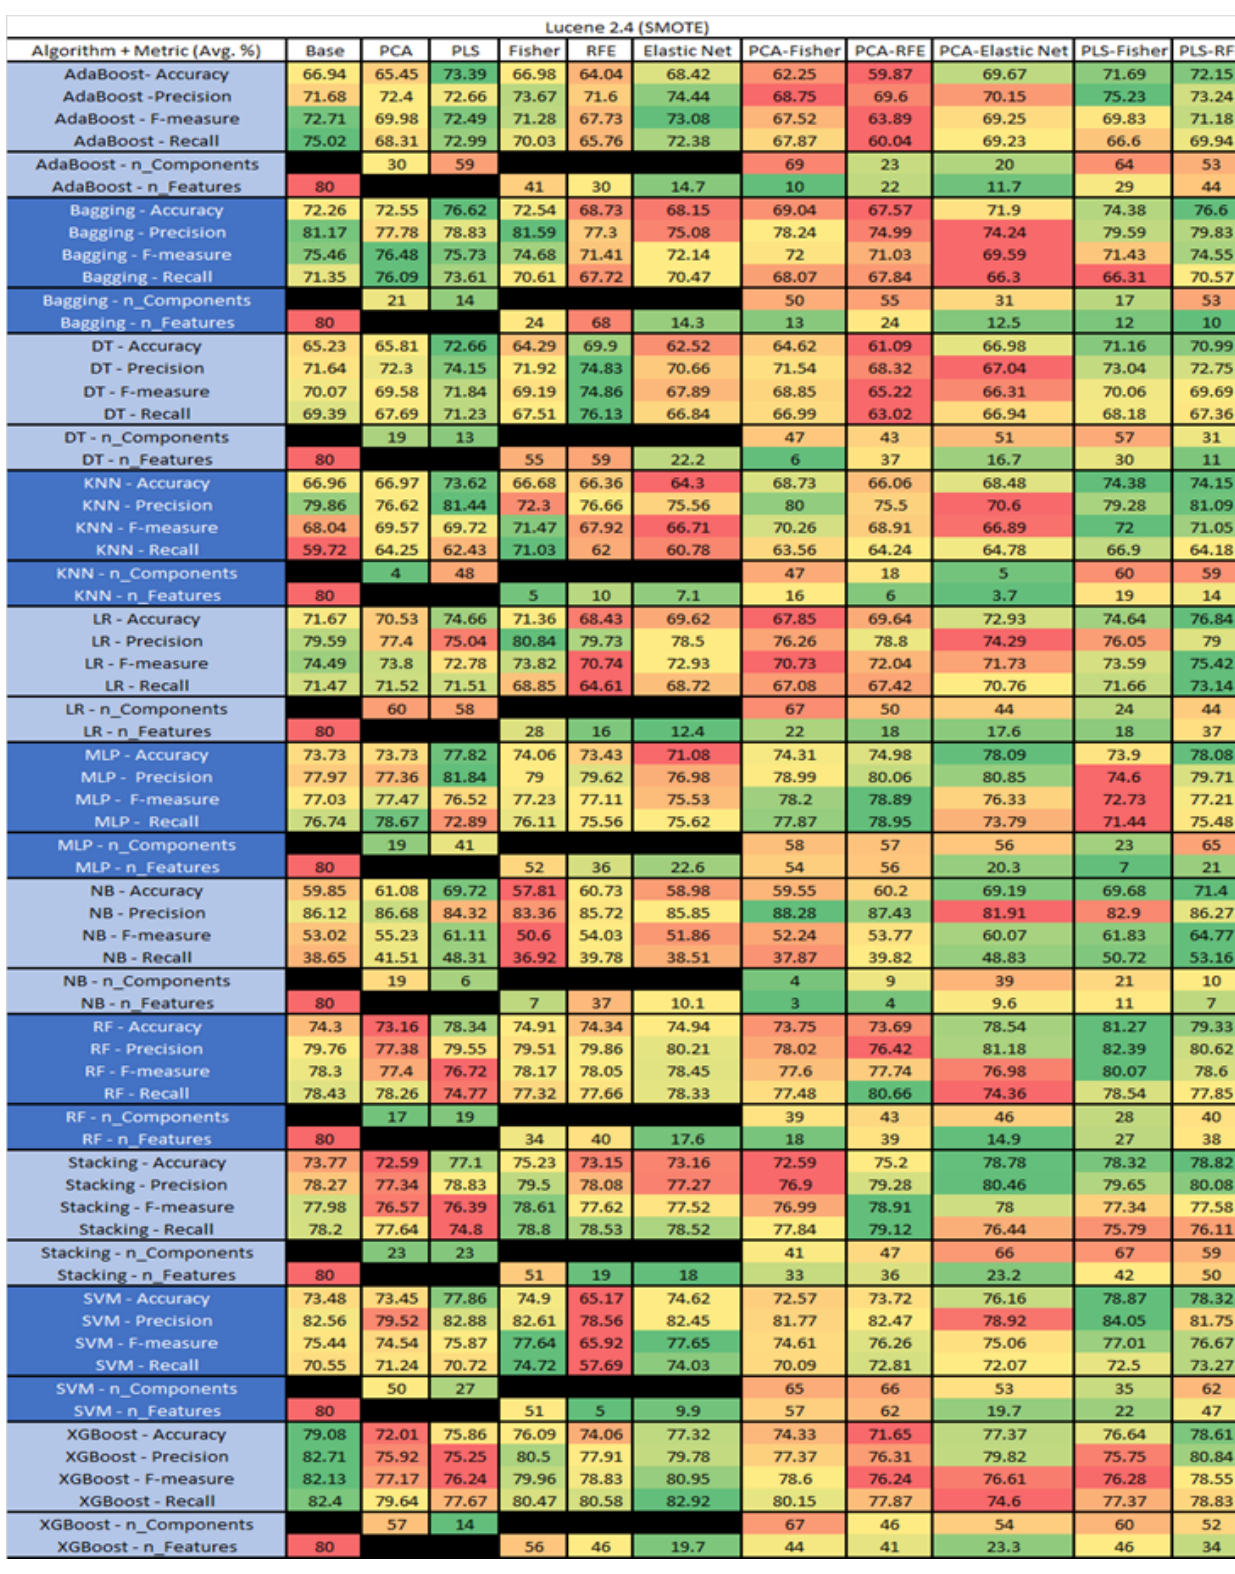
Figure 33. Lucene 2.4 SMOTE PROMISE Results Data